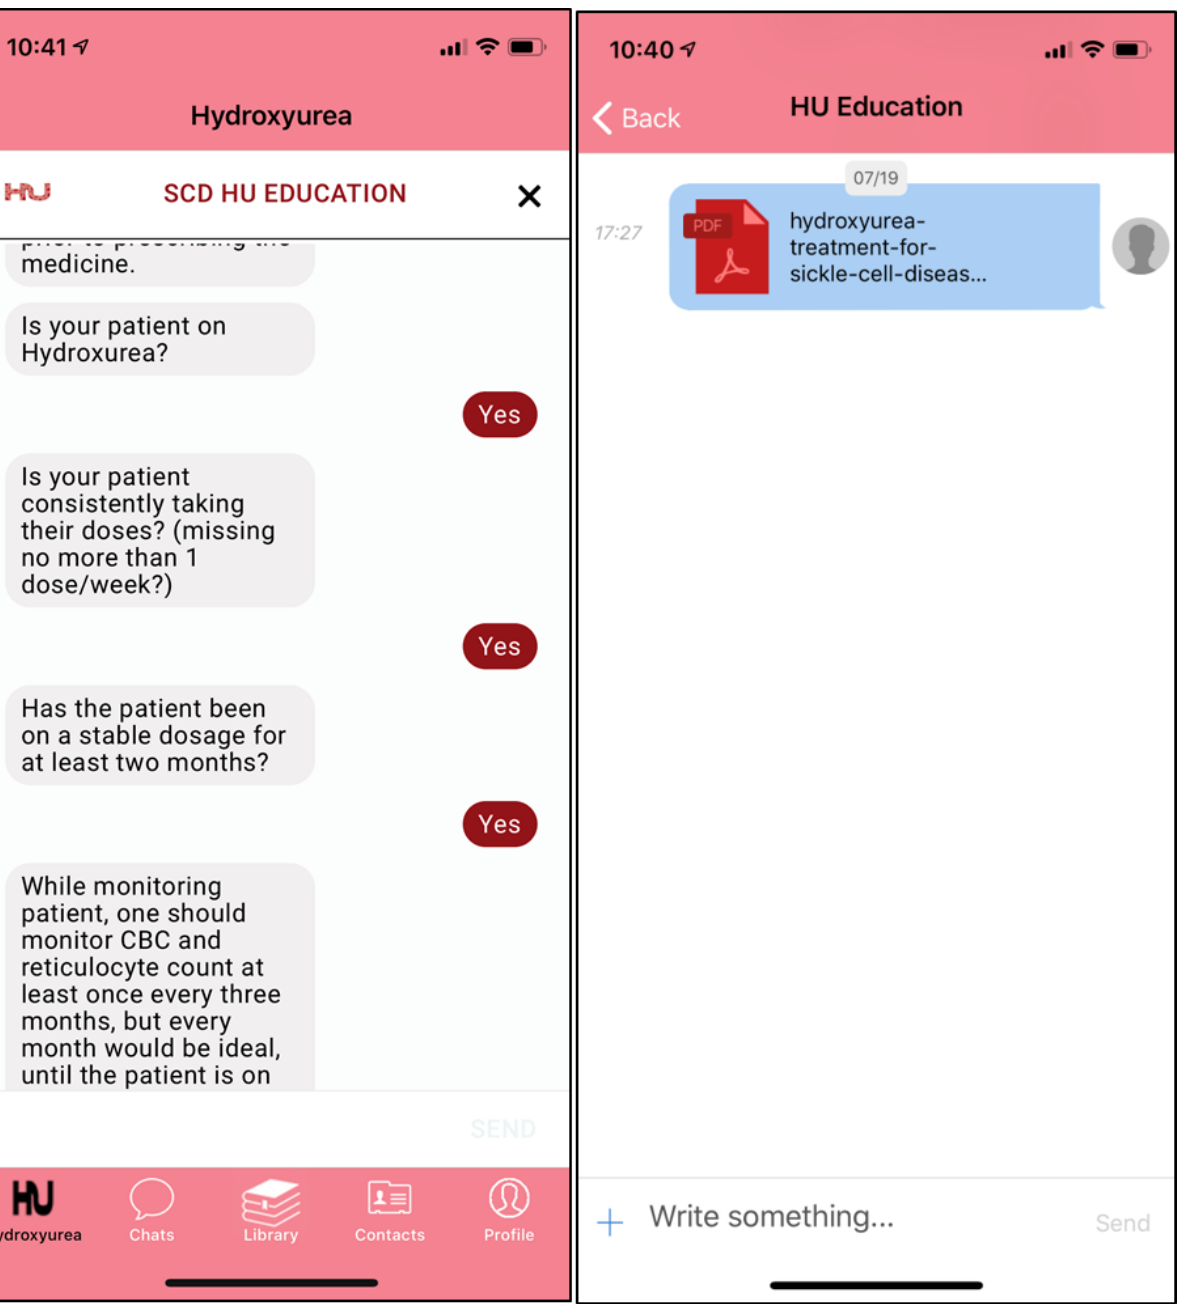
Figure 3. Features of the HU Toolbox mobile app: The HU Toolbox provides tools for medical providers prescribing hydroxyurea. The app provides a chatbot for users to ask questions about how to dose and monitor hydroxyurea effects and side effects (left panel). In addition, there is educational material available in a library (right panel) as well as the ability to chat directly with a local SCD specialist. HU Toolbox: Hydroxyurea Toolbox; SCD: sickle cell